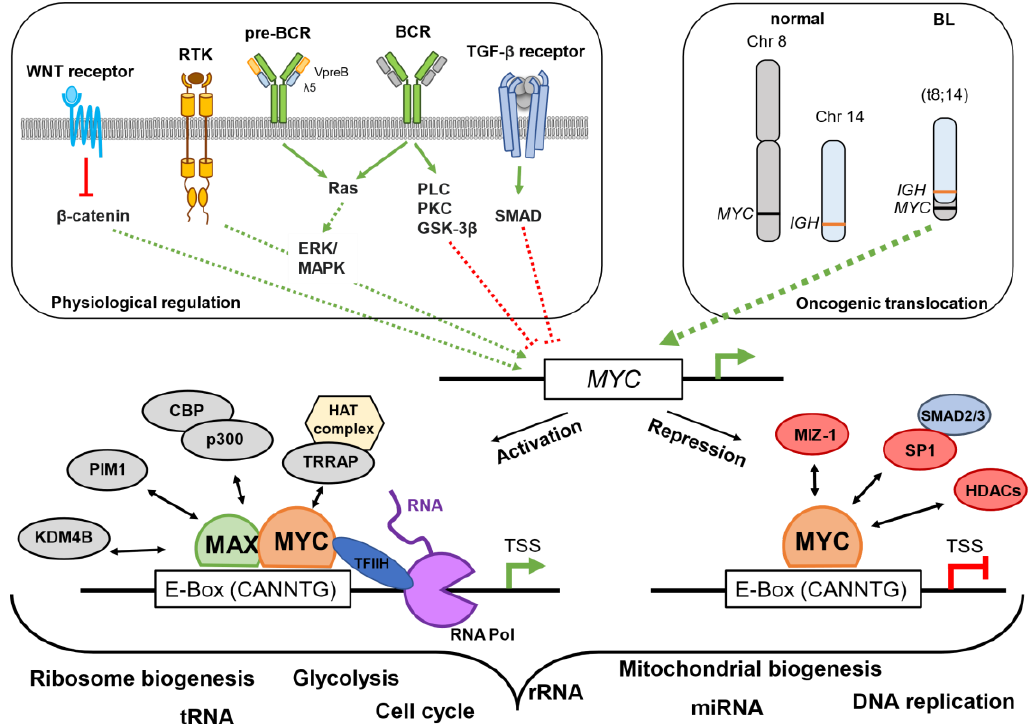
Figure 1. Regulation of the MYC gene and functions of MYC. Shown are pathways that activate or repress MYC transcription. Oncogenic translocations, such as (t8;14) found in human BL, juxtapose MYC and potent enhancers, resulting in high MYC expression. MYC has many interaction partners, leading to context-dependent regulation of biological processes. This scheme summarizes findings from various sources [2,8,20–22]. BCR — B-cell receptor.